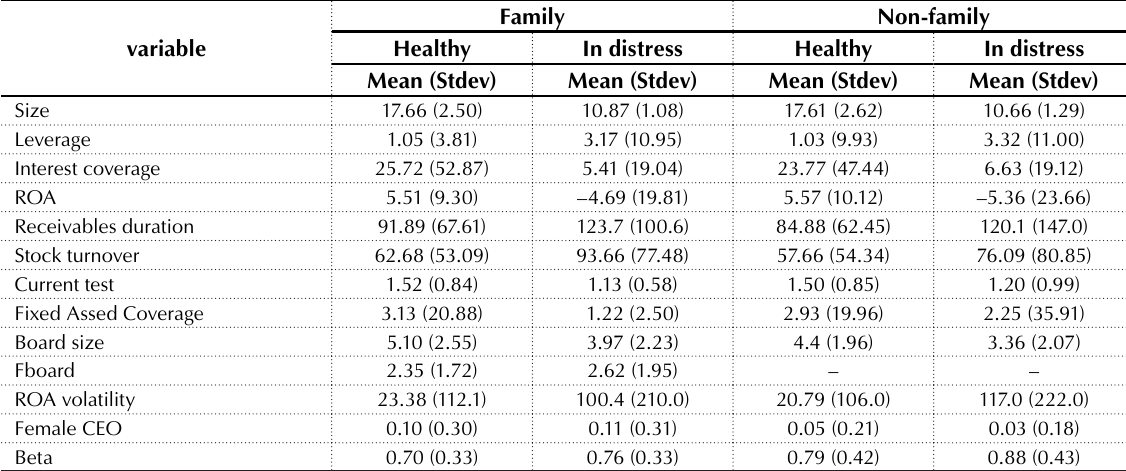
Table 1. Summary statistics of firm characteristics for family and non-family